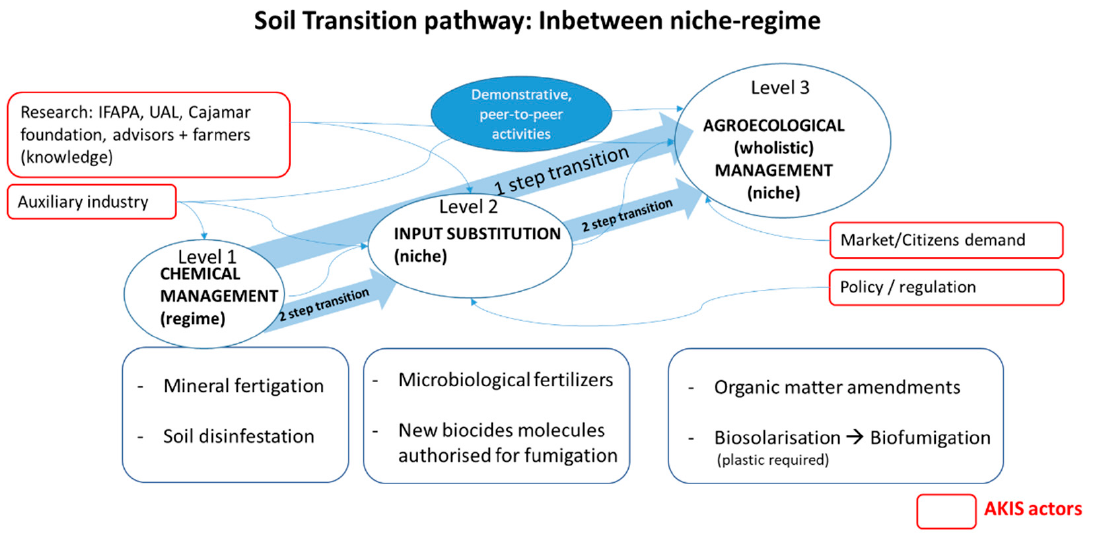
Figure 5. Soil transition pathway (authors’ elaboration).